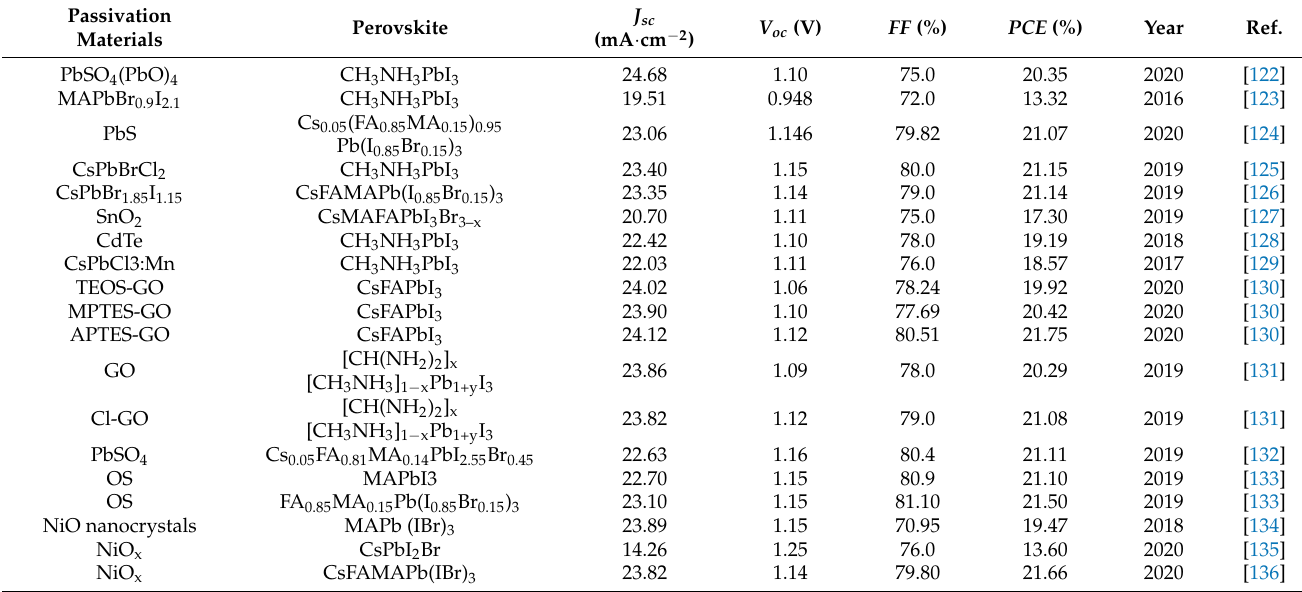
Table 3. Performance summary of inorganic materials passivation